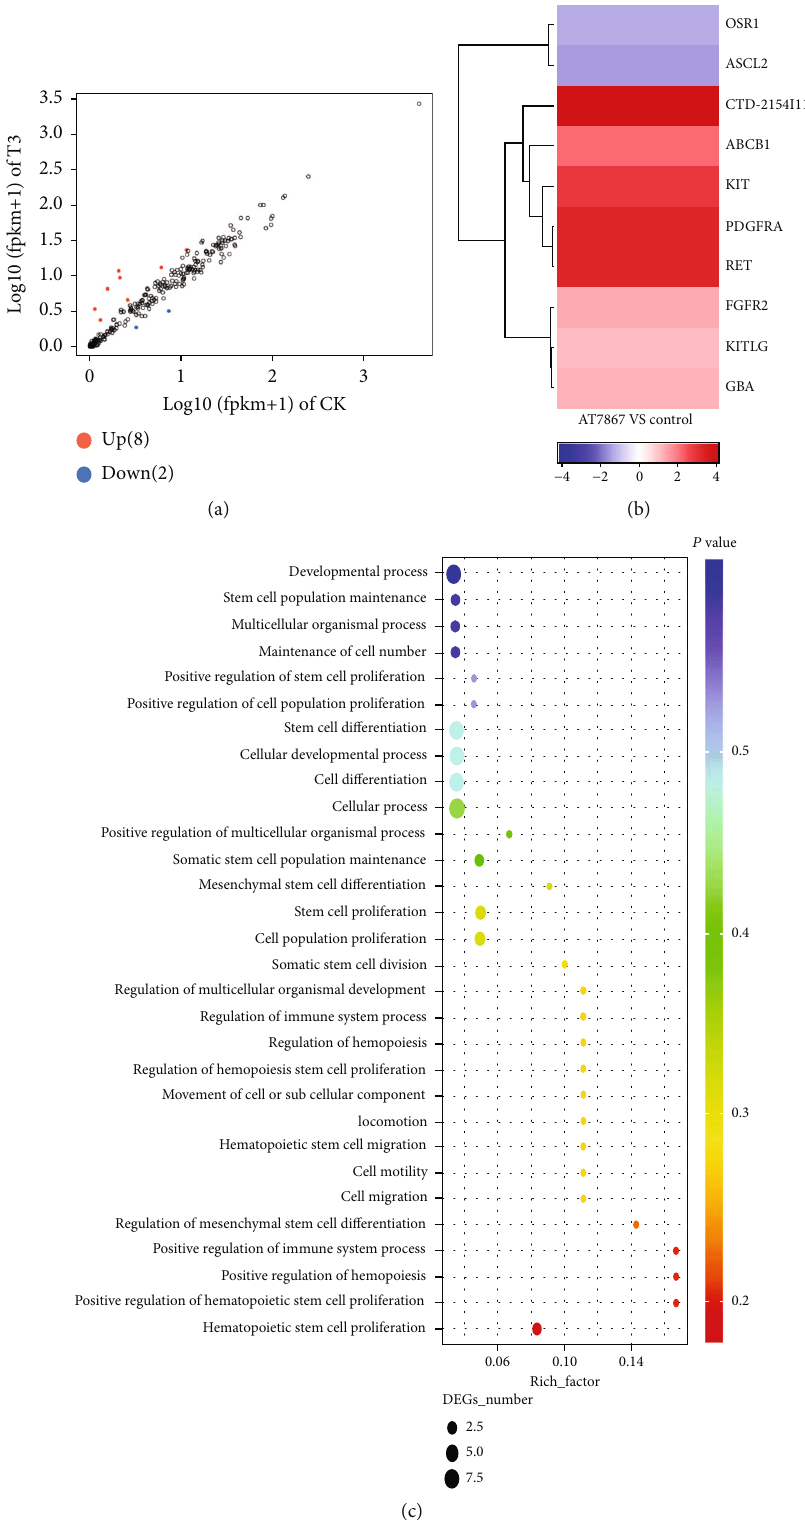
Figure 5: The di ff erentially expressed genes and signal pathways related to cancer stem cells. (a) Di ff erentially expressed genes between AT7867 10 μ M treatment and the control group, with foldchange ≥ 2 and P value ≤ 0.05. (b) Heatmap colored according to the expression PFKM value, showing all of the di ff erentially expressed genes related to cancer stem cells. (c) Pathway is related to cancer stem cell enrichment analysis of DEGs based on the KEGG